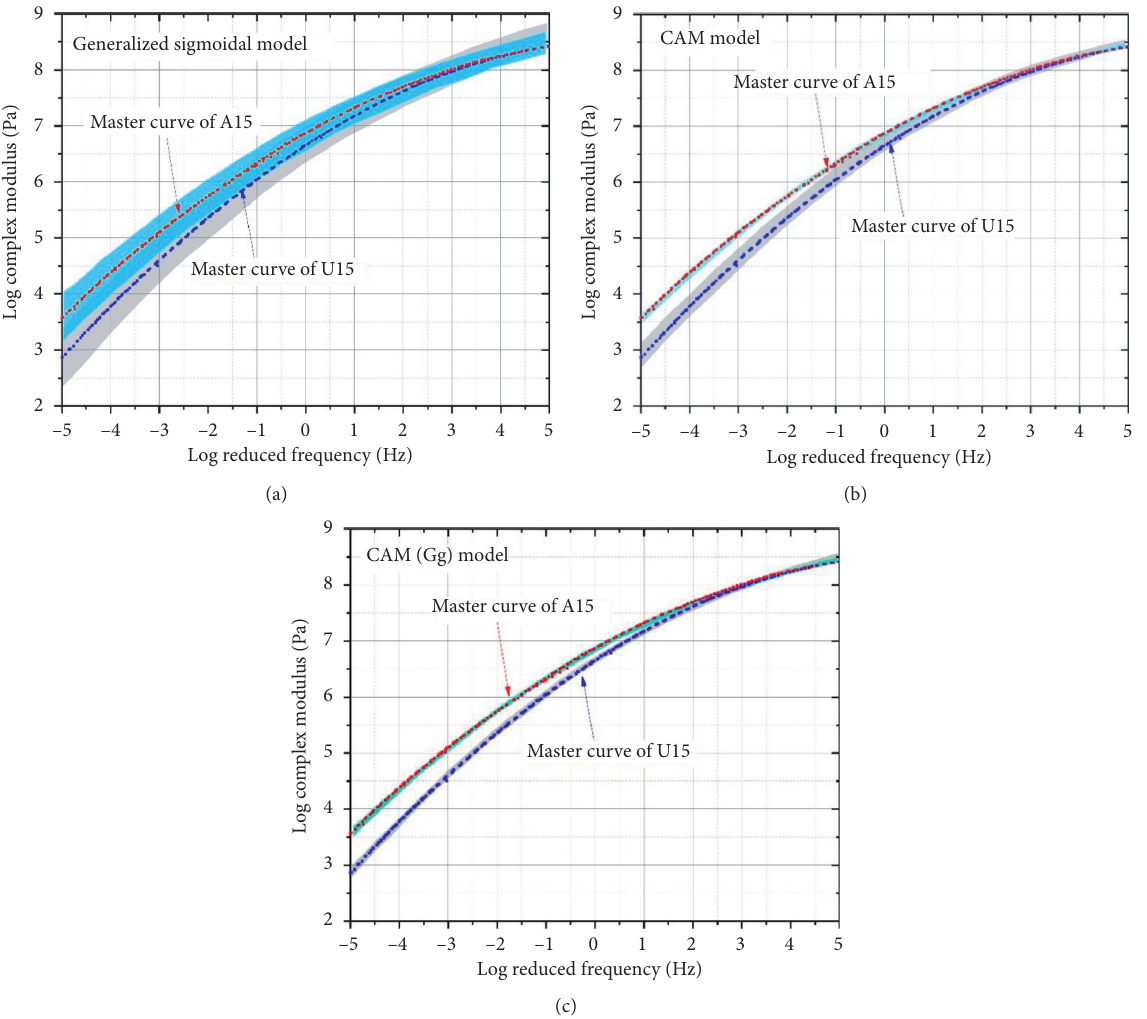
Figure 8: Master-curve band comparison between unaged and aged bitumen. (a) Generalized sigmoidal model. (b) CAM model. (c) CAM (Gg)